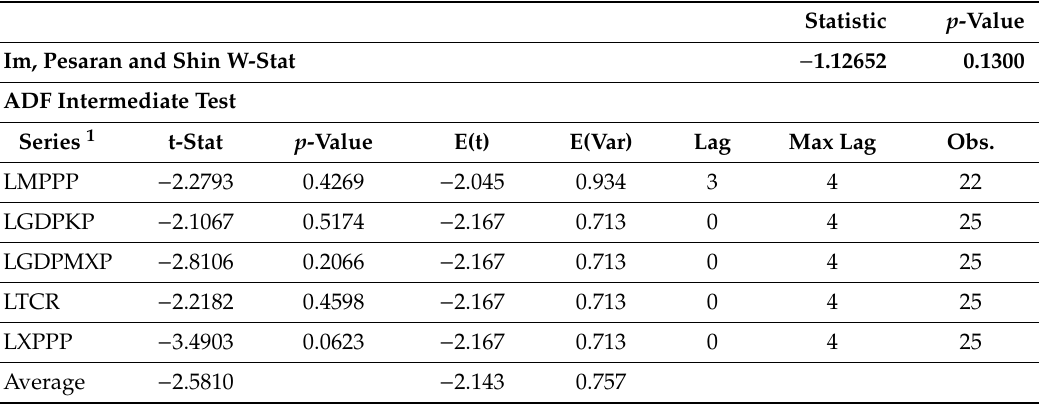
Table 11. Im–Pesaran–Shin Unit Root Tests.